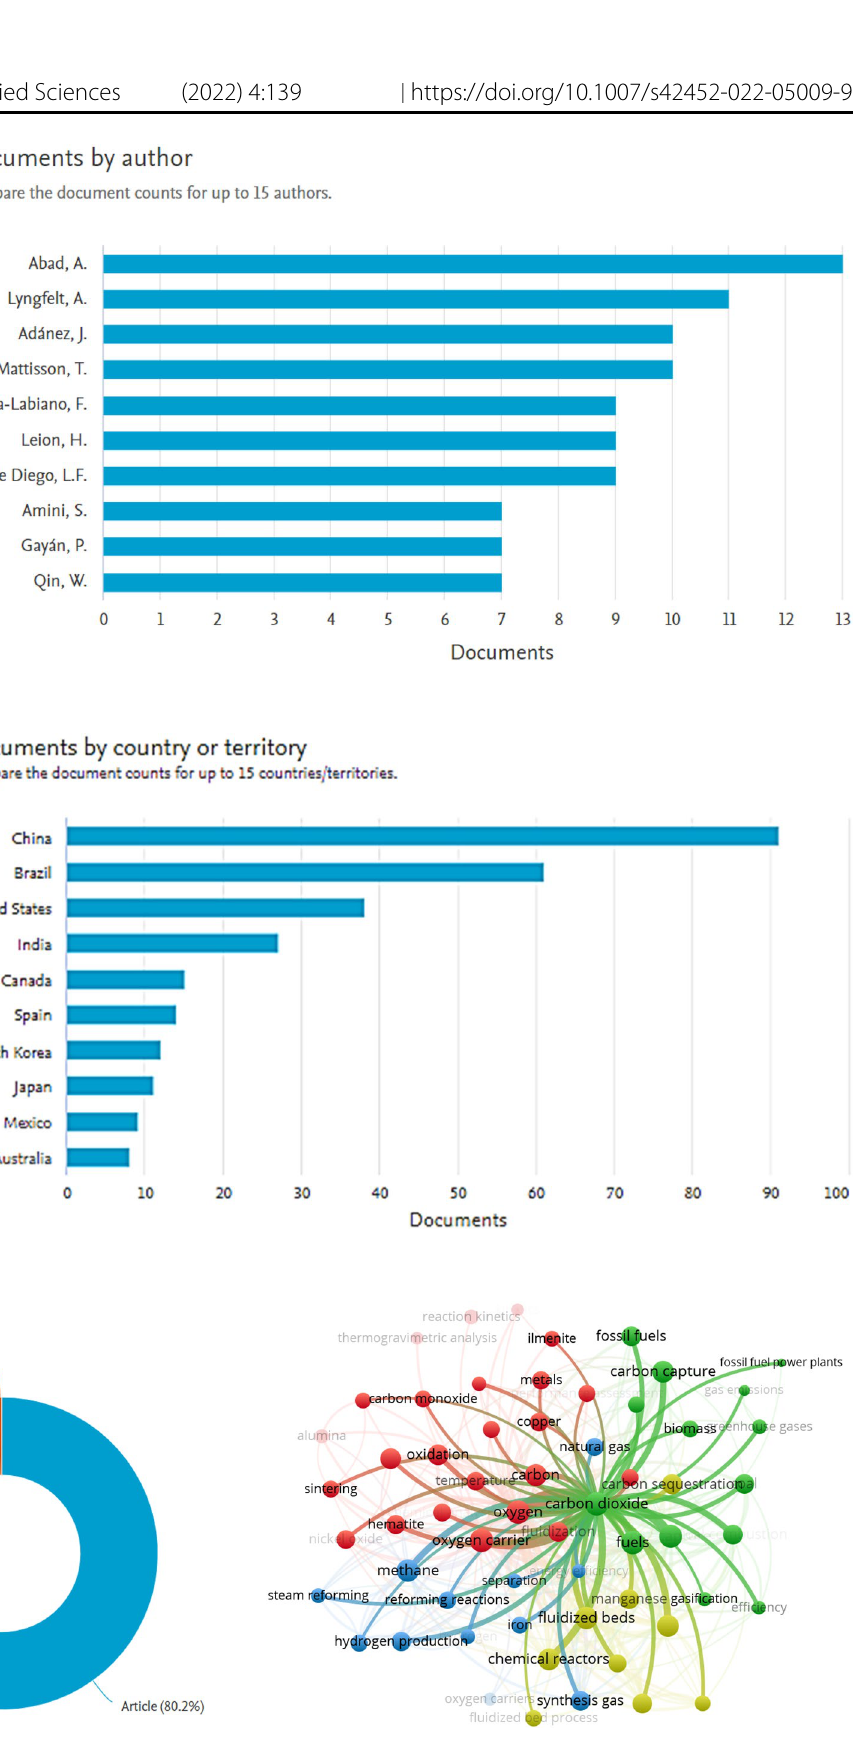
Fig. 10 Bibliometric map (Carbon dioxide) (Source: www. scopus.